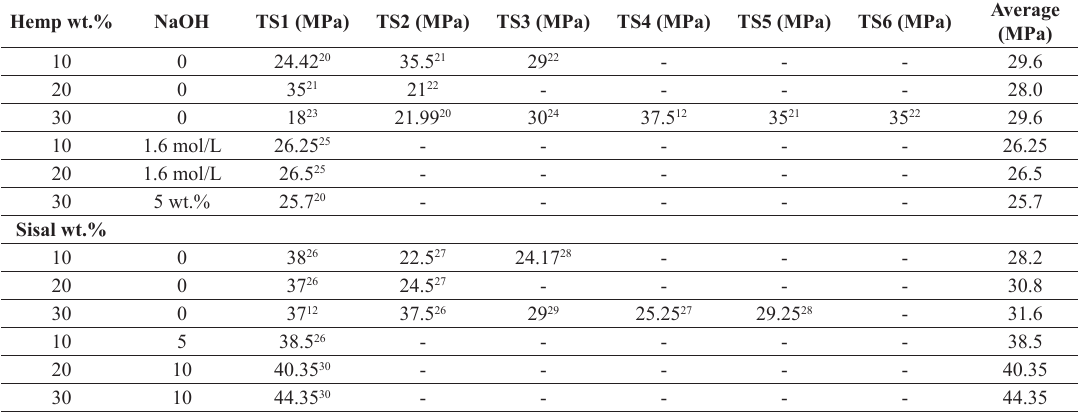
Table 2. The effect of weight percentage of untreated hemp fiber on tensile strength of PP composite. Hemp wt.%